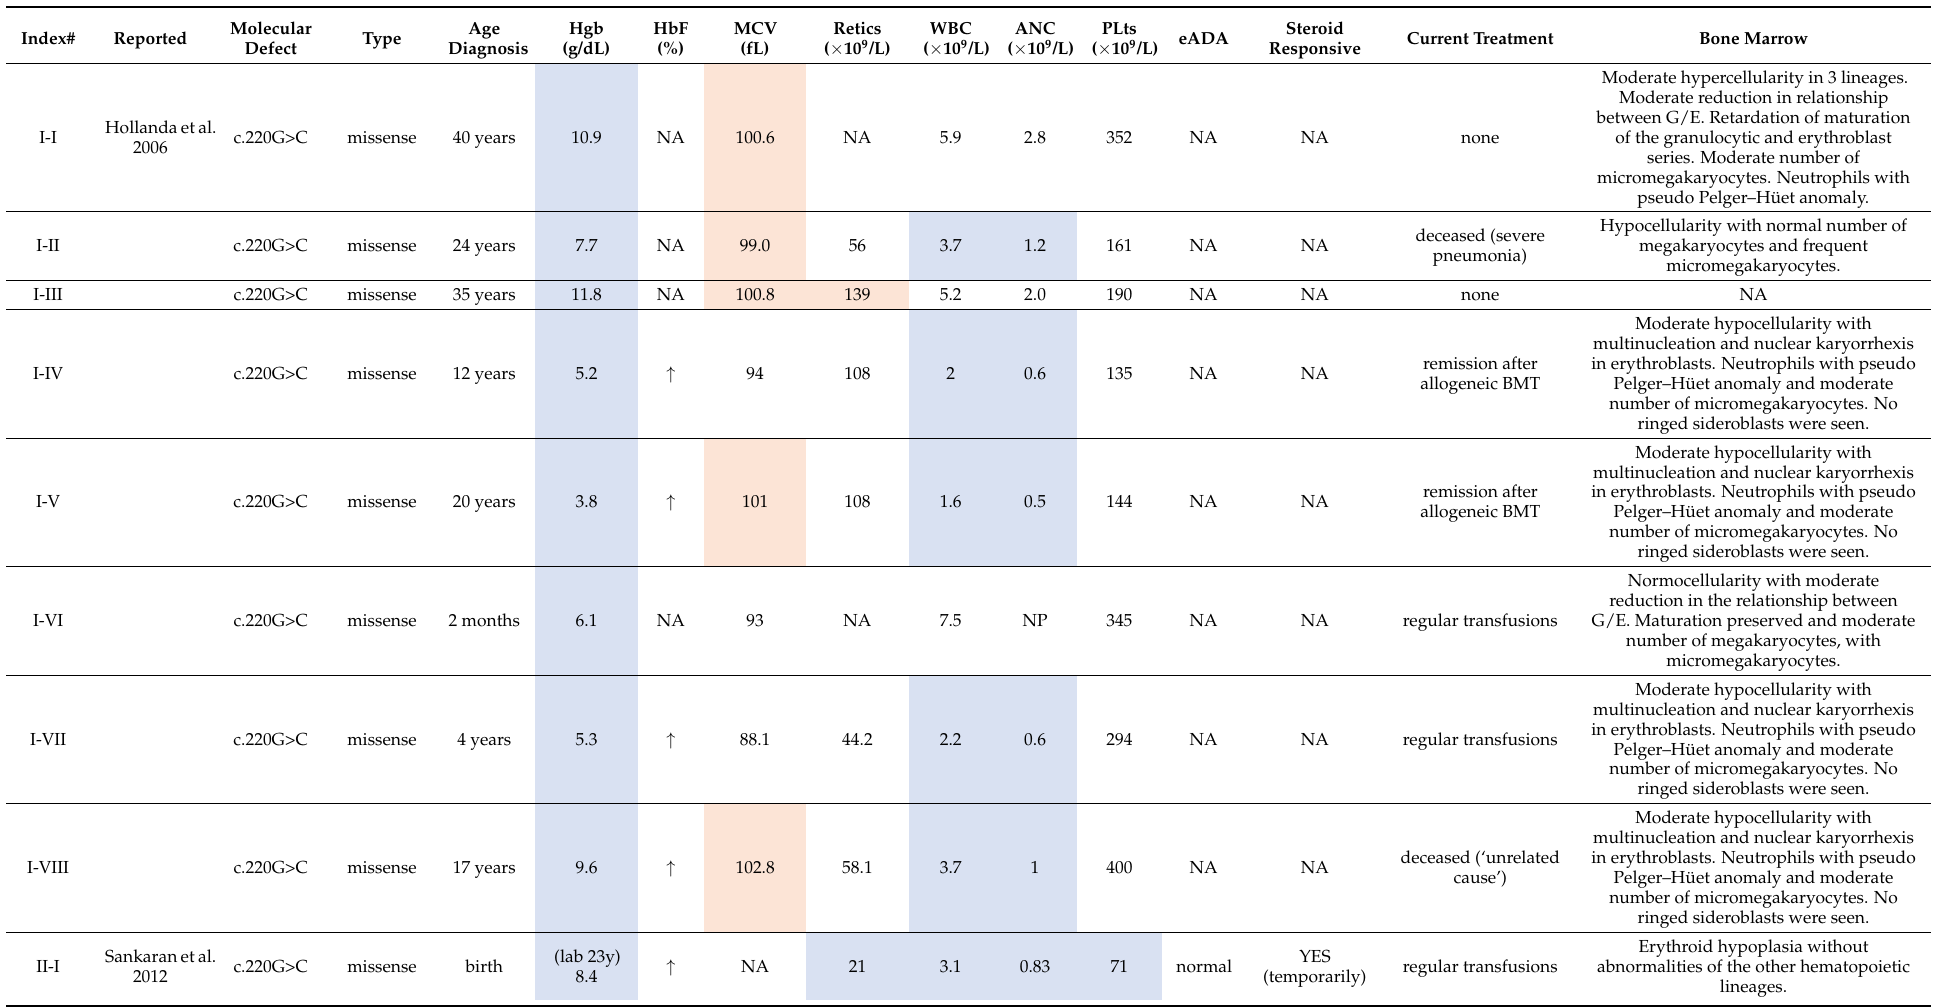
Table 1. Clinical and molecular characteristics of reported